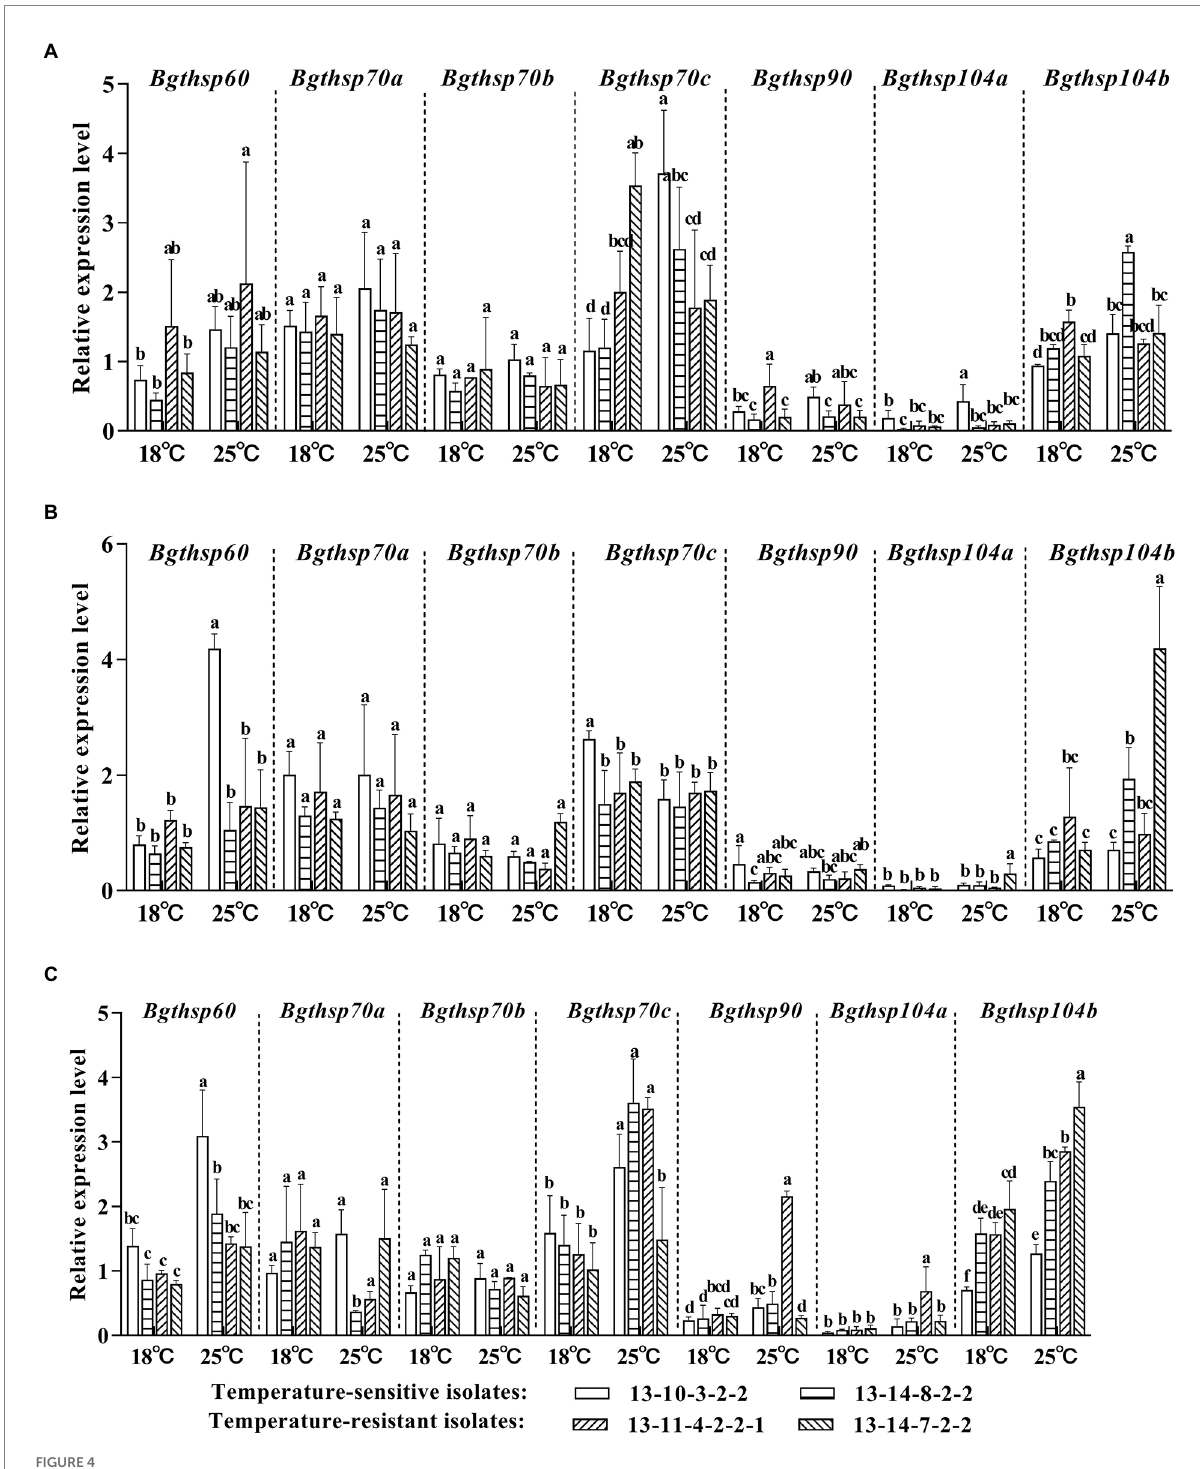
FIGURE 4 Expression levels of Bgthsp60 , Bgthsp70 , Bgthsp90 and Bgthsp104 under different temperature conditions at (A) 24 h post-inoculation (hpi), (B) 48 hpi, (C) 72 hpi. β -tubulin was used as reference gene and 0 hpi of the one independent repeat of 13–10–3-2-2 as reference sample. The error bar showed standard error of three independent repeats. Data were analyzed by two-way ANOVA with Duncan’s multiple range test. The different letters above the error bars indicated significant differences ( p ≤